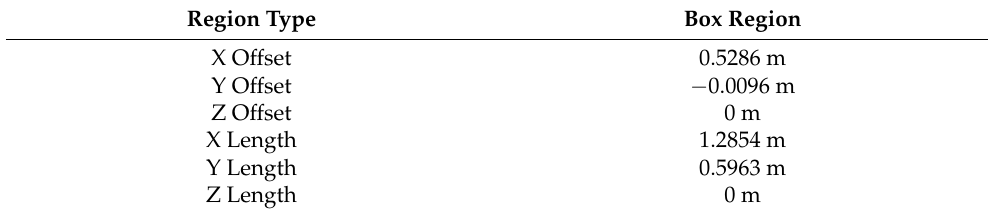
Table 4. Mesh Refinement Regions for the 2D Model.